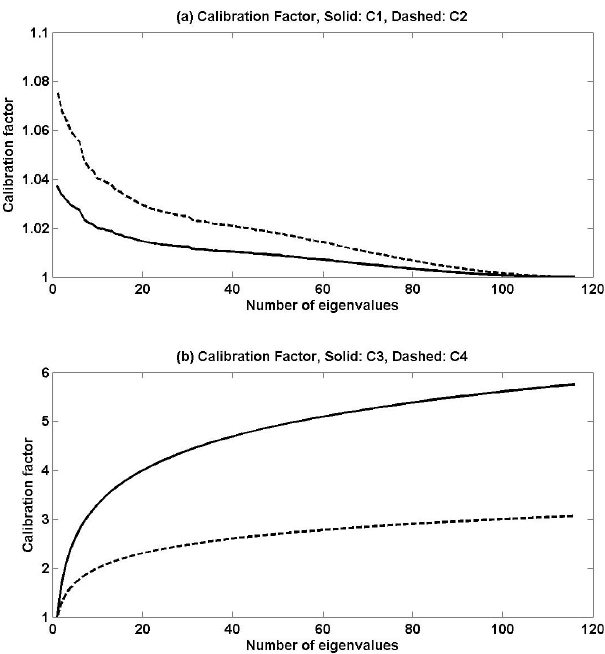
Fig. 7. Four calibration factors as functions of number of eigenval- ues for C 1 (solid) and C 2 (dashed) in (a) and C 3 (solid) and C 4 (dashed) in (b) for K = 116 and ndat =